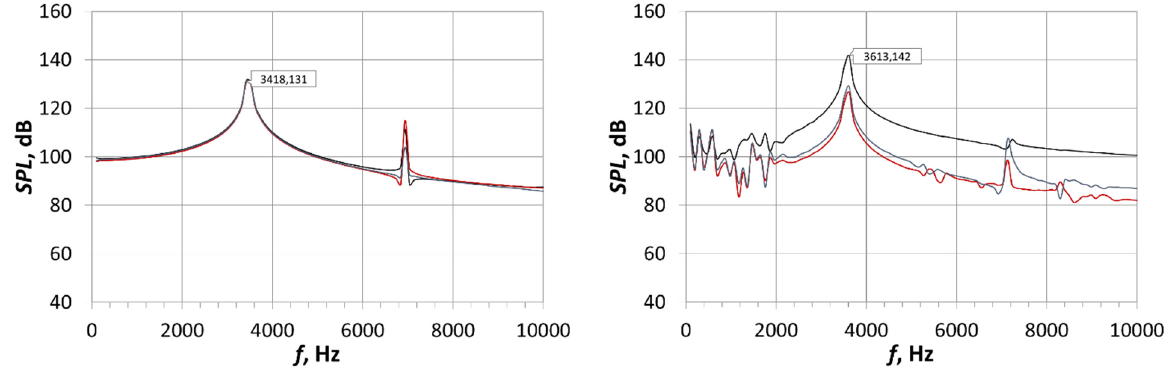
Figure 20. Spectral analysis of SPL for velocity equal to 70 m/s—CFD.